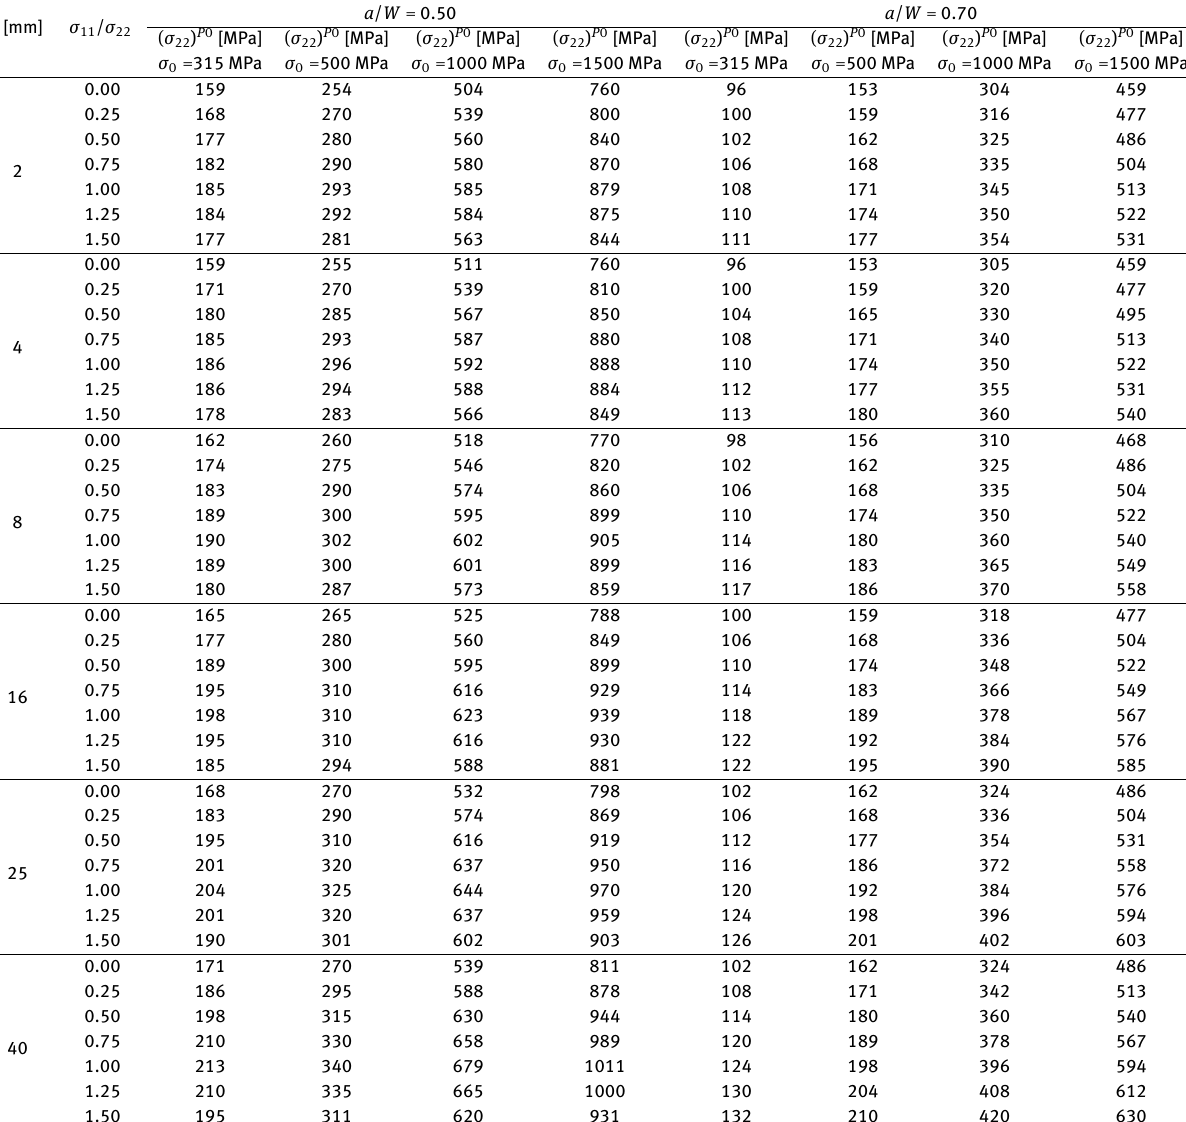
Table 5: Numerically calculated values of the limit load ( σ 22 ) P 0 for CCSP(BT) (3D problems) at the relative crack lengths a / W = 0.50 and a / W =